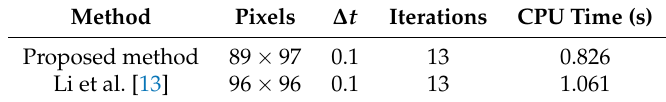
Table 2. Time step size ∆ t , the number of iterations, and CPU time (s) used in Figure